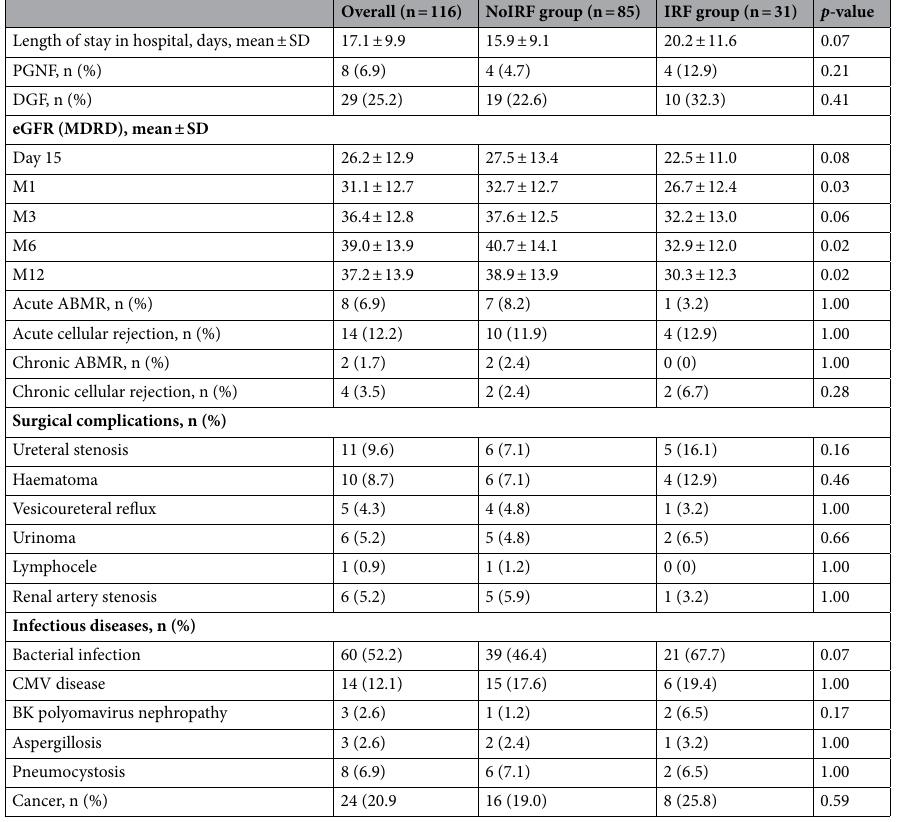
Table 3. Post-transplantation outcomes with comparison according to a peak serum creatinine over 1.0 mg/ dl and/or a transient oligo-anuria in the donor. ABMR antibody-mediated rejection, CMV